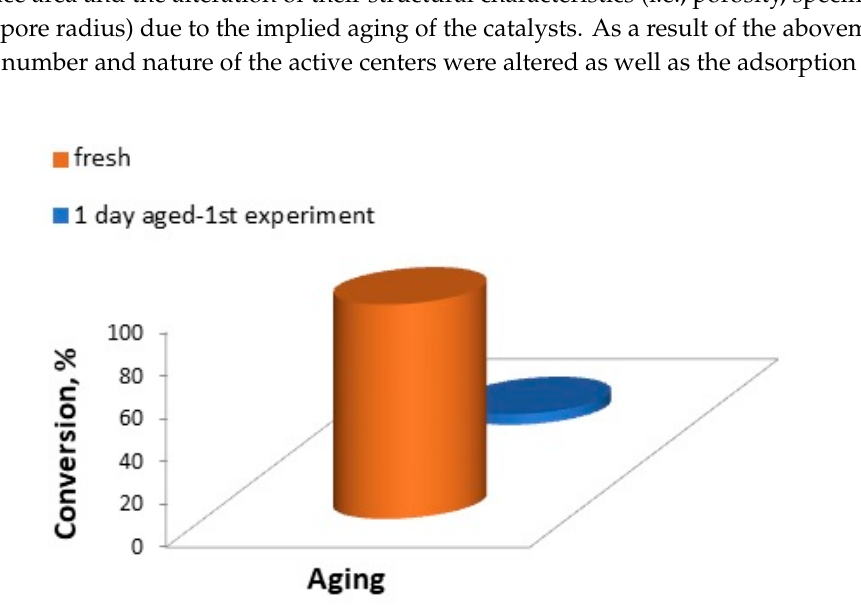
Figure 7. Influence of the effect of aging on the conversion of maleic acid in the Ni nanocatalyst produced by SCS (at 80 °C).